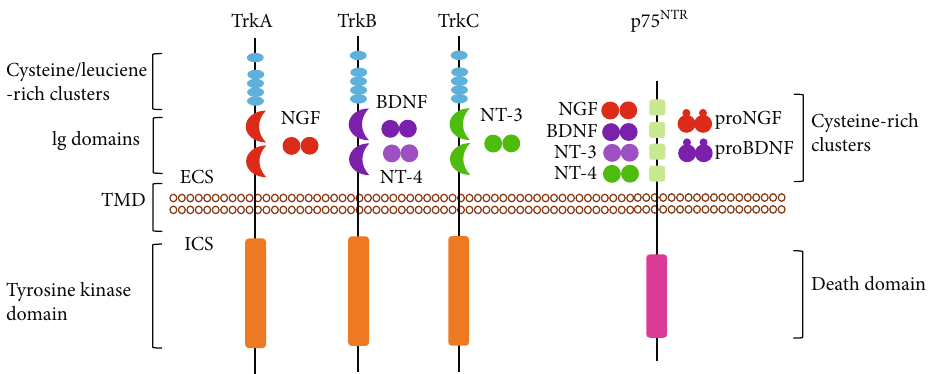
Figure 2: Schematic of neurotrophins and their target receptors. NGF, BDNF/NT-4, and NT-3 bind to TrkA, TrkB, and TrkC, respectively, with high a ffi nity. While these neurotrophins can all also bind to p75 NTR with low a ffi nity, the proneurotrophins proNGF and proBDNF can bind and activate the p75 NTR receptor with high a ffi nity. Trk: tropomyosin receptor kinase; NGF: nerve growth factor; BDNF: brain-derived neurotrophic factor; NT: neurotrophin; Ig: immunoglobulin; TMD: transmembrane domain; ECS: extracellular space; ICS: intracellular space. This cartoon is adopted from Sanchez-Sanchez et al. with modi fi cations